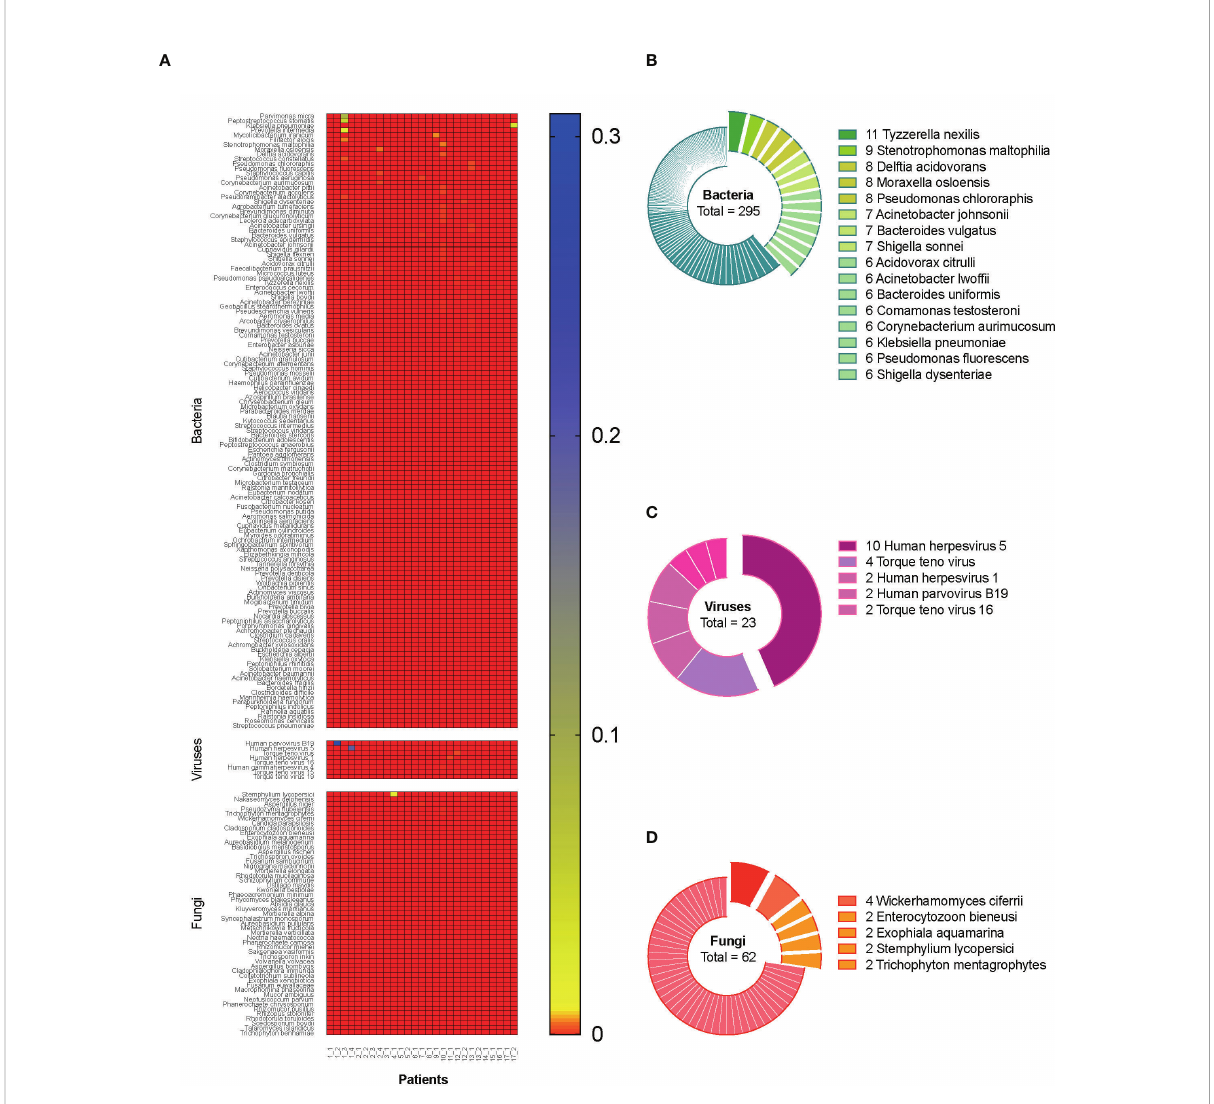
FIGURE 2 Metagenomic information of pathogens in the plasma. A total of 27 blood samples from 17 included septic CSI patients were tested by mNGS. (A) Relative abundance of pathogens in all the blood samples. (B – D) The frequency of each identi fi ed pathogen. Stratum-speci fi c analyses. N = 27. CSI, cervical spine injury; mNGS, metagenomic next-generation